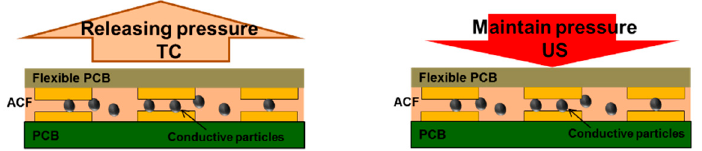
Figure 3. The comparison of the completed moment between thermo-compression (TC) and ultrasonic (US) bonding: Releasing pressure and maintaining pressure.